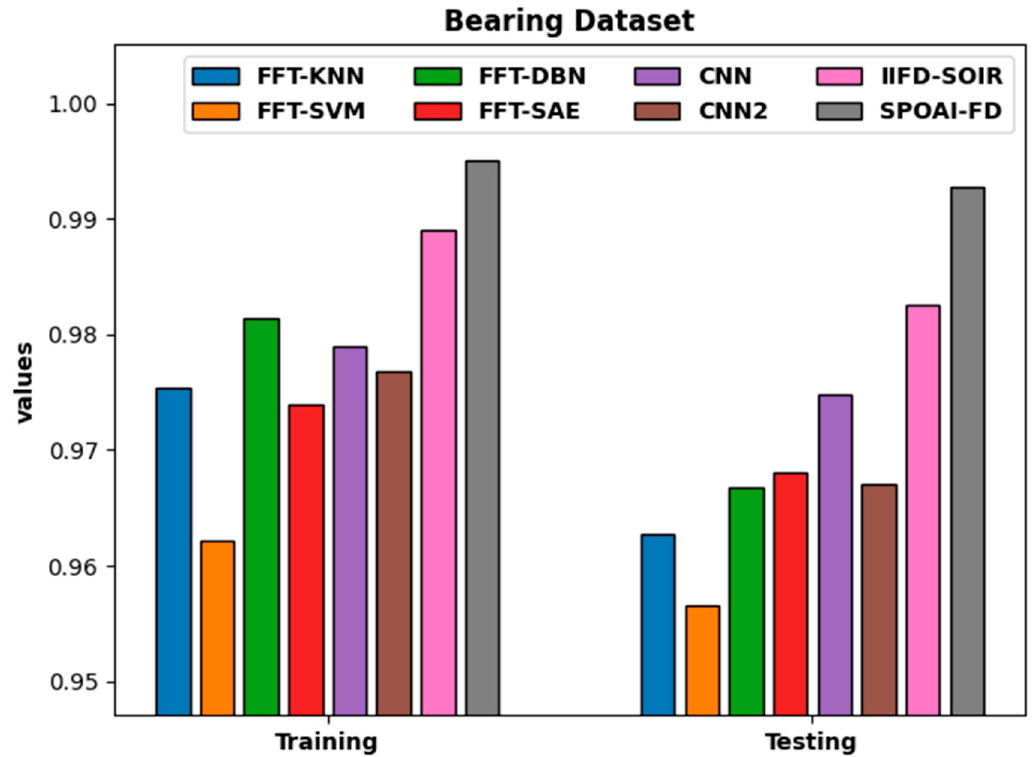
Figure 11. Comparative analysis of the SPOAI-FD technique under Bearing dataset